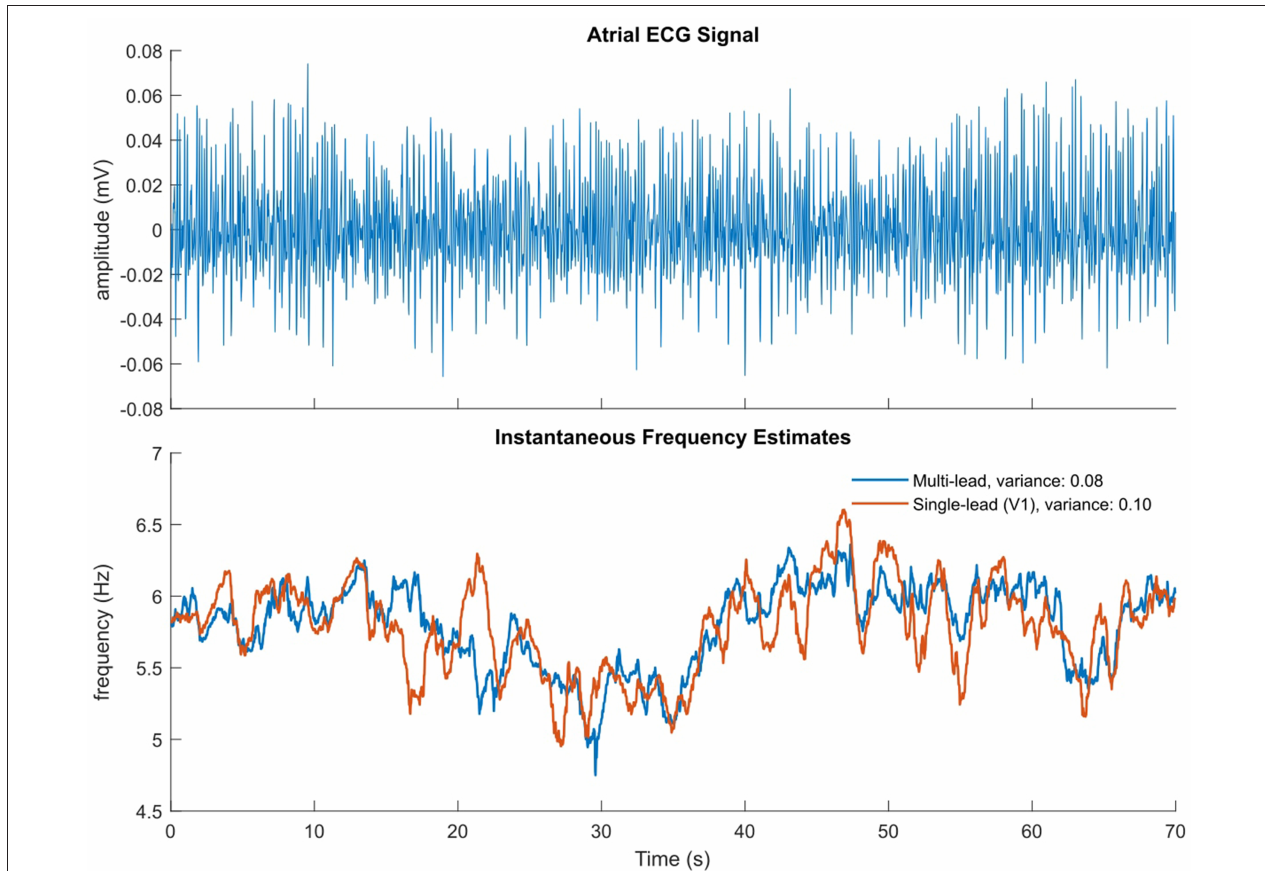
FIGURE 1 | Illustrative example of multi-lead vs single-lead IF estimate. (Top) Atrial ECG signal with ventricular complexes removed, on which the single-lead estimate is calculated. (Bottom) Multi-lead IF estimate in blue, single-lead ( V 1 ) estimate in